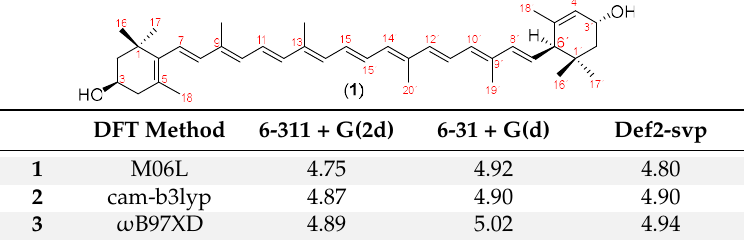
Table 3. p K a values of H-6’ in (3 R ,3’ R , 6’ R )-lutein ( 1 ) calculated with different functionals and basis sets.